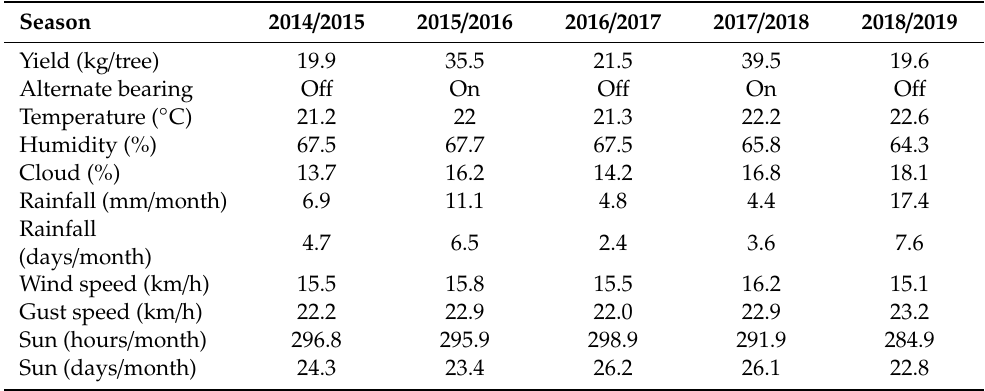
Table 9. Yield of untreated “Ewais” mango trees during five years, associated with average weather data per year calculated from September to August of each season. Yield LSD = 3.5 ( P ≤